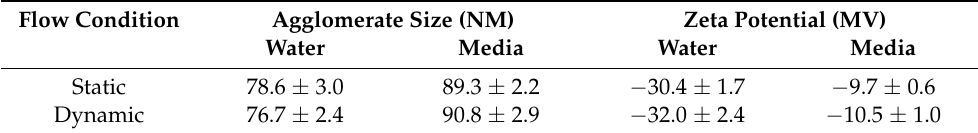
Table 1. Characterization of the AgNPs under static and dynamic